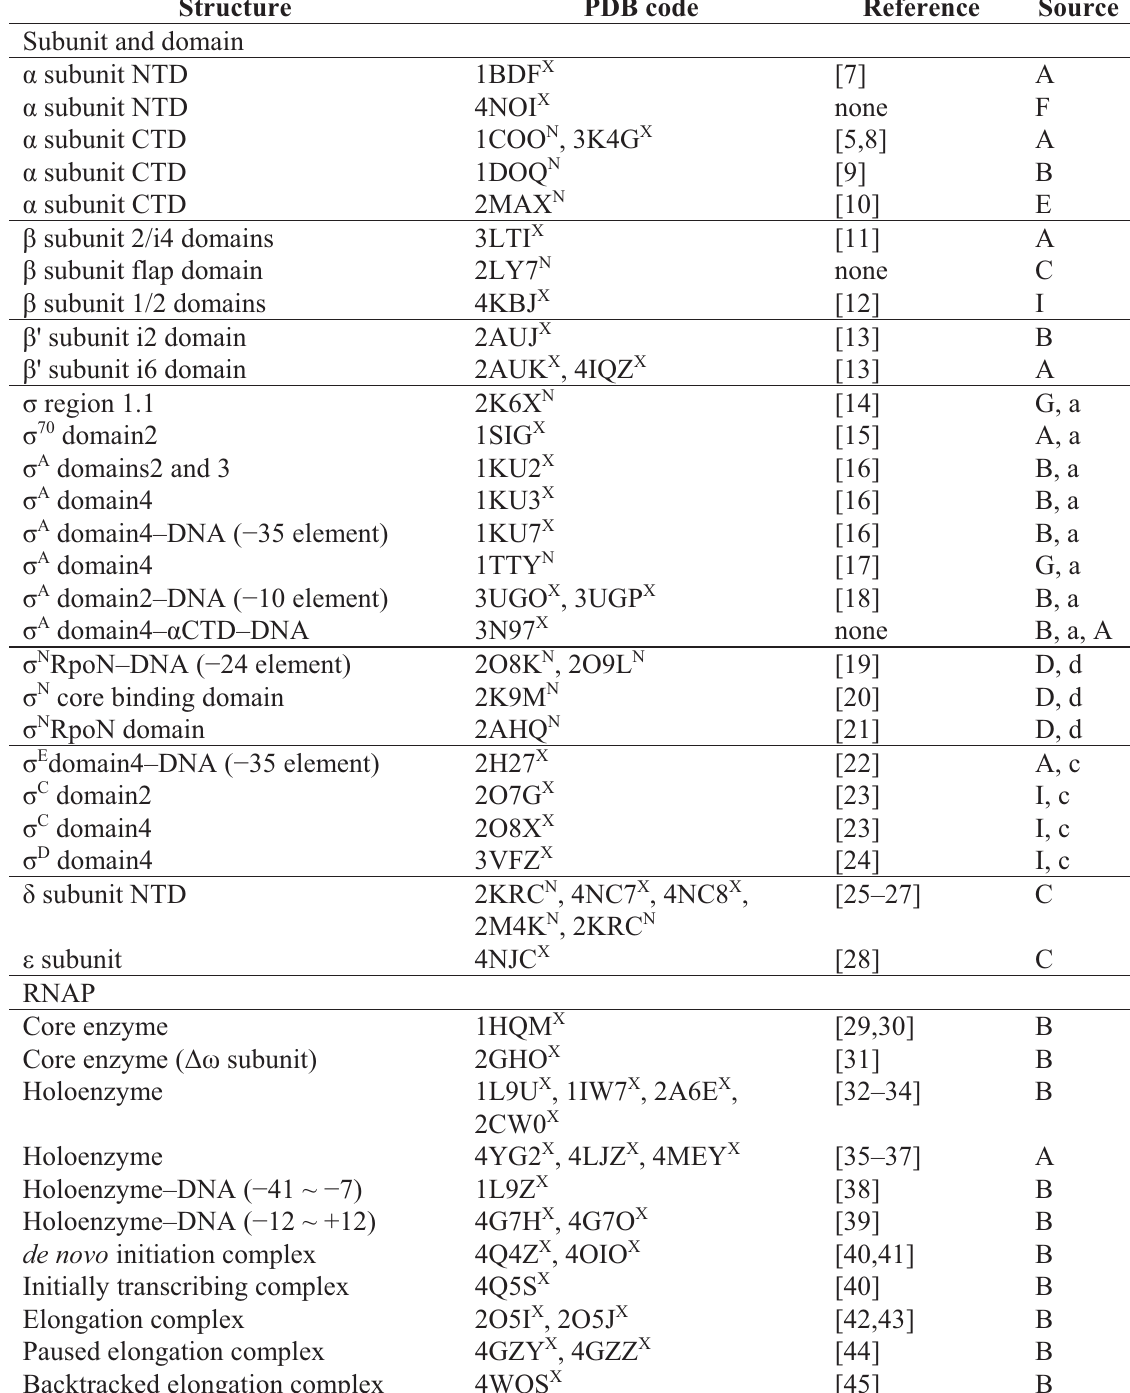
Table 1. Structural information on bacterial